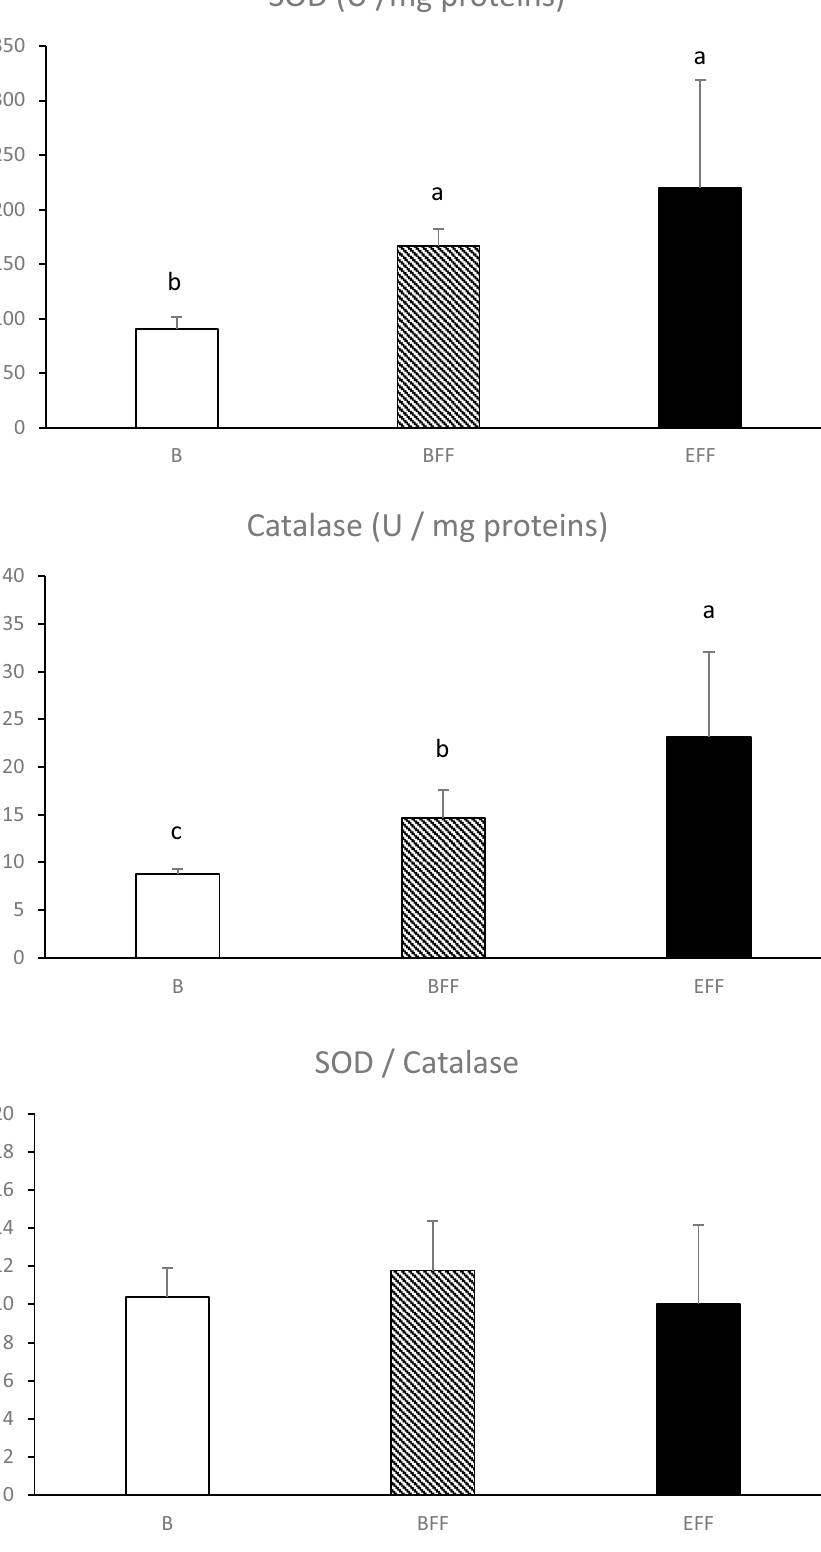
Figure 1. Activities of superoxide dismutase (SOD) and catalase enzymes in livers collected before (B) or at the beginning (BFF) or at the end (EFF) of the force-feeding period. Values are means ± SD. Bars with different letters differ (p <